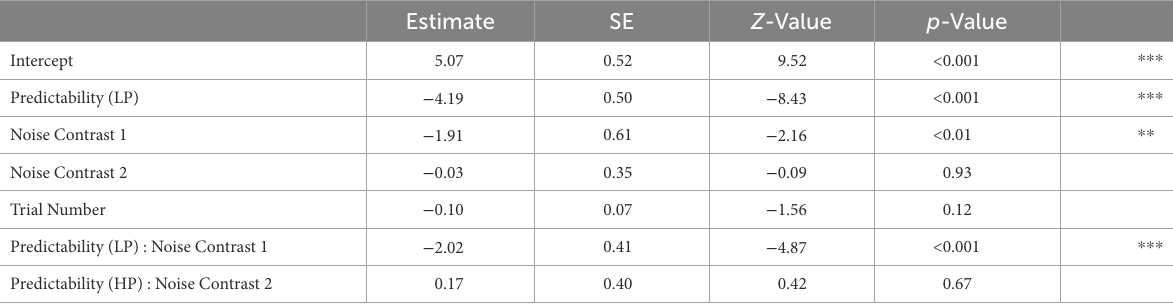
TABLE 2 Model outcomes for the overall model (predictability * noise interaction). Estimate